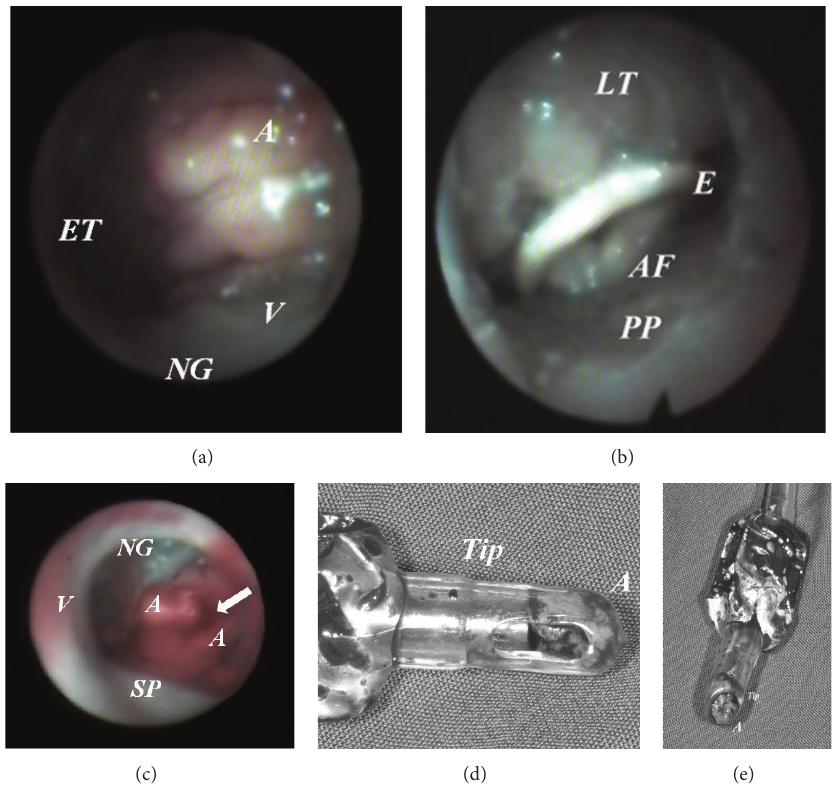
Figure 1: Hypertrophic adenoid avulsed by a nasotracheal tube. Hypertrophic adenoid viewing by a fiberscope (a). Hypertrophic lingual tonsil (b). Avulsed hypertrophic adenoid; a groove appear on the adenoid (c). Tip of the nasotracheal tube was filled with adenoid tissue but side hole was not occluded (d and e). A: adenoid hypertrophy; AF: arytenoid folds; E: epiglottis; ET: eustachian tube; LT: lingual tonsil; NG: nasogastric tube; PP: posterior pharyngeal wall; SP: soft palate; V: